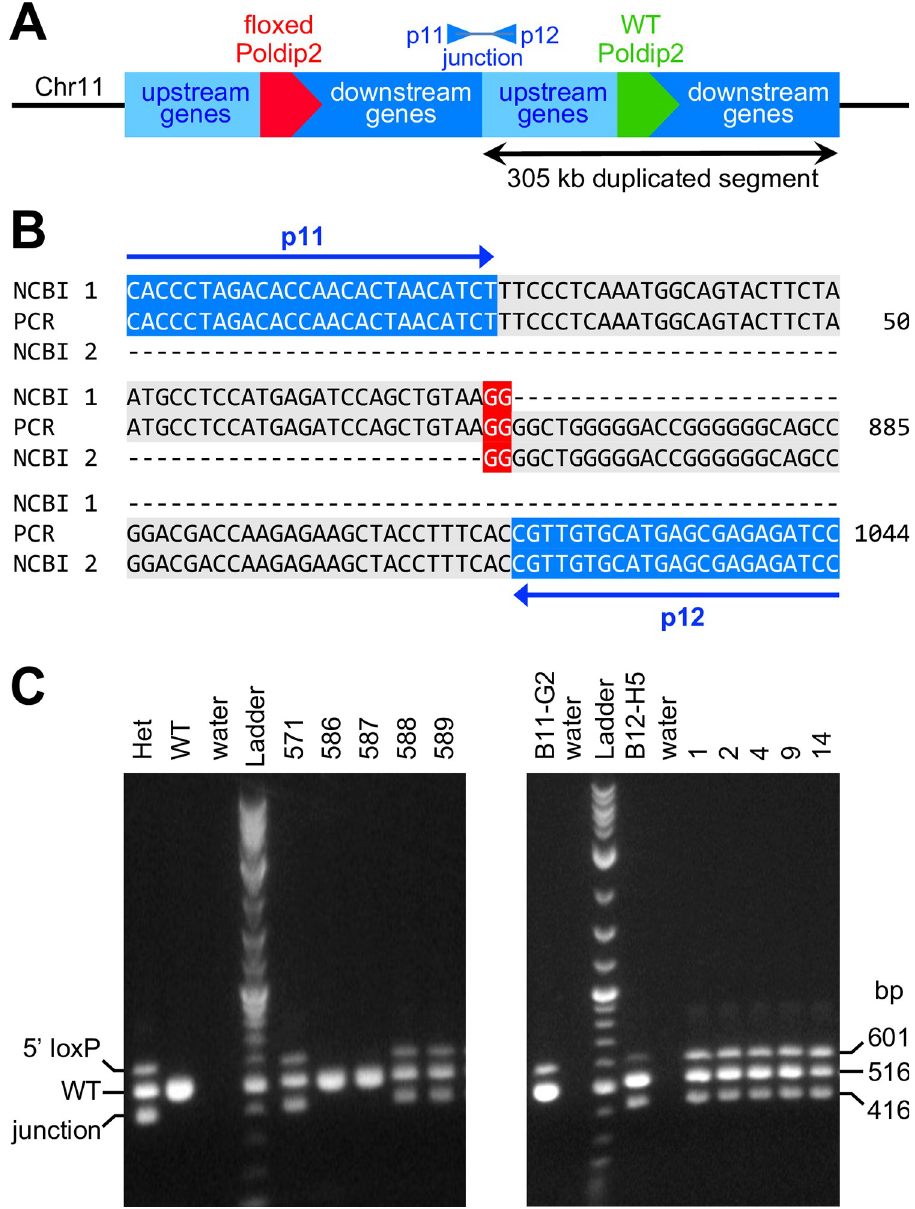
Fig 5. Elucidation of the rearrangement structure provides a new genotyping method. A: Schematic of a possible genomic rearrangement with both duplicated segments located side by side in the same orientation and connected by a junction. One copy carries floxed Poldip2 , while the other retains the WT allele. B: Genomic DNA from a homozygous floxed Poldip2 mouse was amplified by PCR with primers p11 and p12, designed to anneal near the edges of the duplicated segment. A single ~1 kb PCR product was generated, thus confirming the structure proposed in panel A. Following cloning and sequencing of the PCR product, its 1,044 bp sequence was used in a BLAST search of NCBI’s mouse genome. The alignment shows the ends and the center of the PCR product, including primers highlighted in blue and the GG doublet at the junction highlighted in red. Nucleotides 1–862 are 100% identical to a DNA segment (NCBI 1) located downstream of Poldip2 , while nucleotides 861–1,044 are 100% identical to a DNA segment (NCBI 2) located upstream of Poldip2 . Sequence coordinates from NCBI GRCm38.p6 (5’ end 78,328,894 and 3’ end 78,634,062) provide the exact length of the duplication: 305,169 bp, thus refining the result from Fig 4B. C: A new genotyping method with two primer pairs was designed to detect both the 5’ loxP site (p7 & p8 as in Fig 2) and the duplication junction (p13 & p12) in a single PCR tube. A number of floxed Poldip2 mice were re-genotyped with this new method with the hope of finding floxed animals without duplication. A representative gel (left) shows that the floxed allele and the mutation were always detected together. Furthermore, the duplication was also found in DNA samples from the